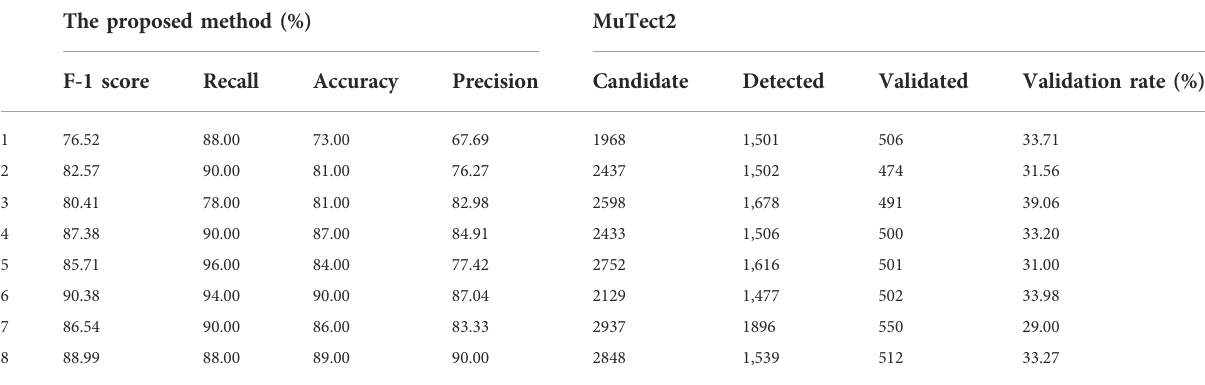
TABLE 6 The experiment results on real